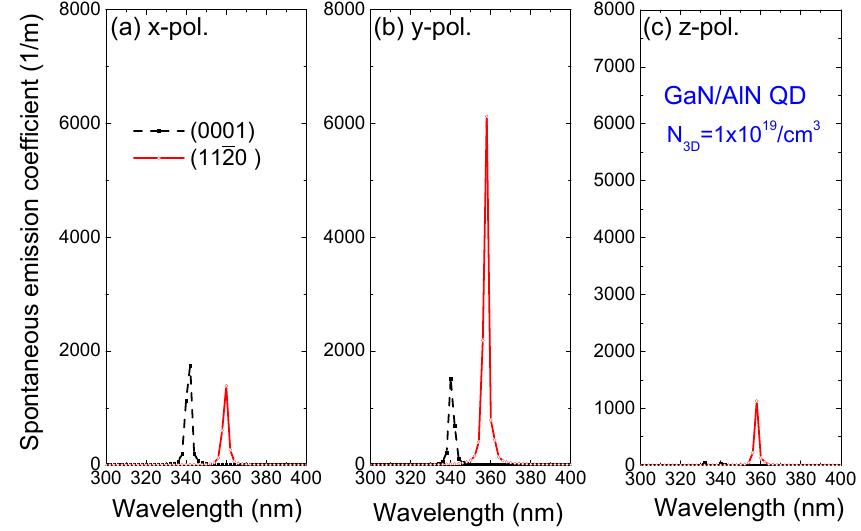
Figure 5. Spontaneous emission spectra for x -, y -, and z -polarizations for (0001)- and (11¯20)-oriented a-plane GaN/AlN QD structures grown on GaN